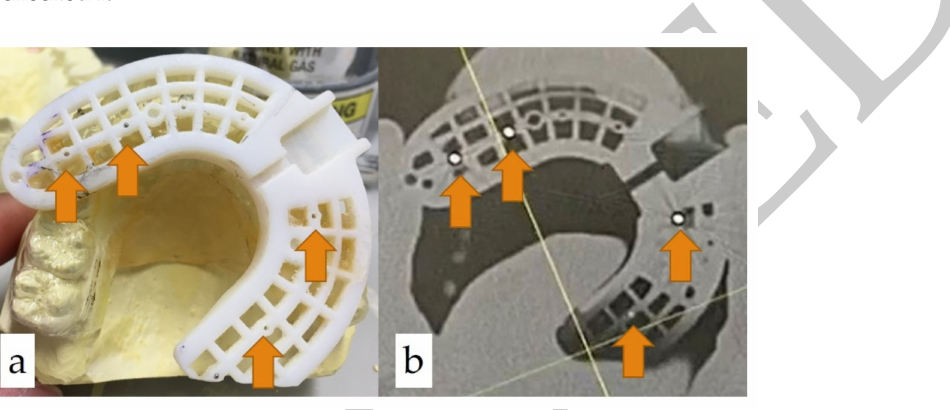
Figure 1. Preoperative procedure: ( a ) prefabricated thermoplastic stent with fiducial markers (small titanium discs; arrow heads); ( b ) CBCT image.